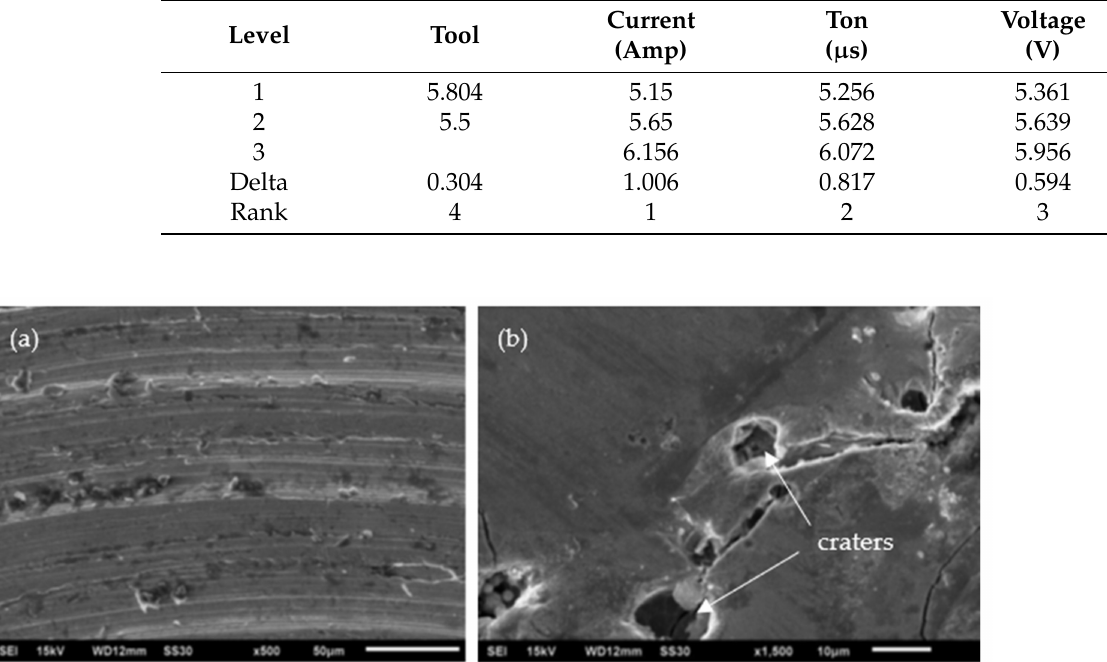
Figure 6. Main effects plots (means) for SR ( µ m). (units: current (Amp), voltage (V), T on ( µ s).) Table 8. Response table for SR ( µ m).